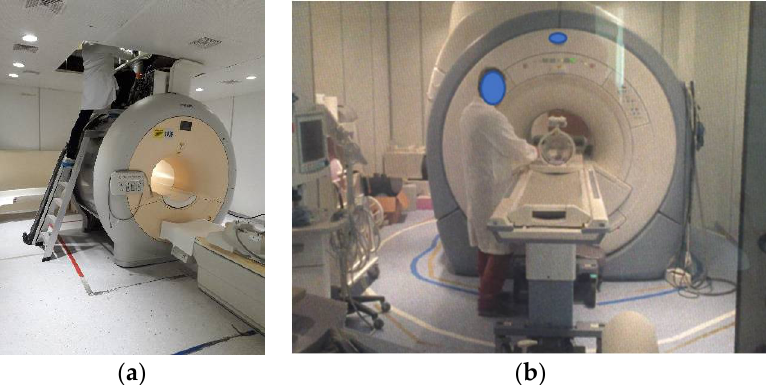
Figure 1. ( a ) Scanner #1: Philips 3T, worker: maintenance technician, task: oxygen sensor replacement. ( b ) Scanner #2: GE 3T, worker: researcher (engineer), task: tactile stimulation during fMRI protocol.